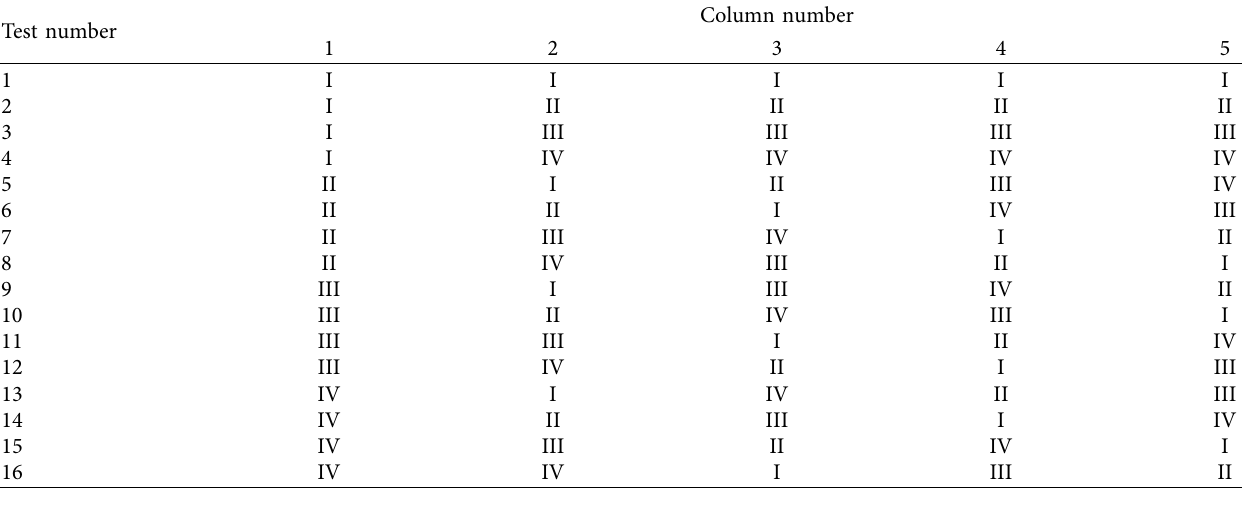
Table 2: Orthogonal experiment table L16 (4 5